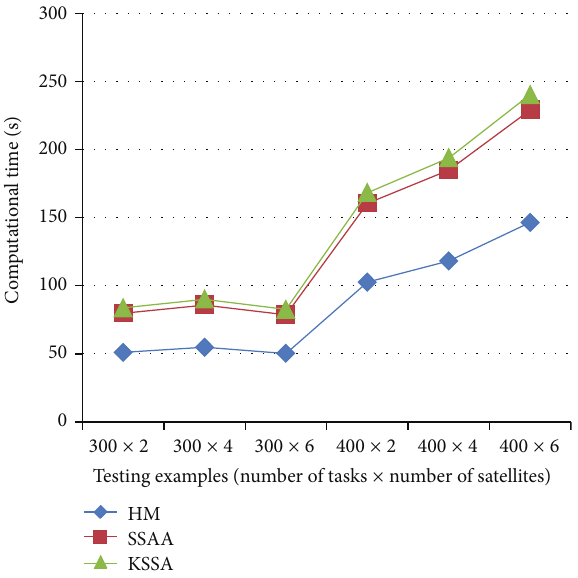
Figure 4: Experimental results in computational time of small scale testing examples.